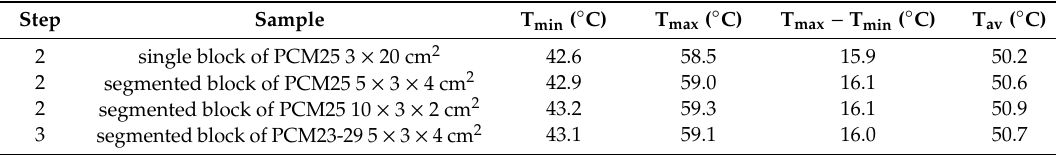
Table 4. Minimum (bottom), maximum (top) and average temperatures of the PCM after 16 h. Step